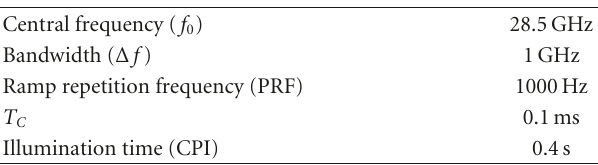
Table 2: Real radar parameters for the acquired data corresponding to the sailboat in Figure